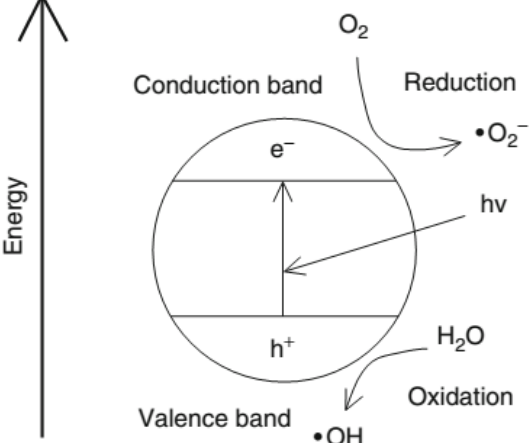
Fig.5: Photopromotion of an electron, reduction of oxygen and oxidation of water.